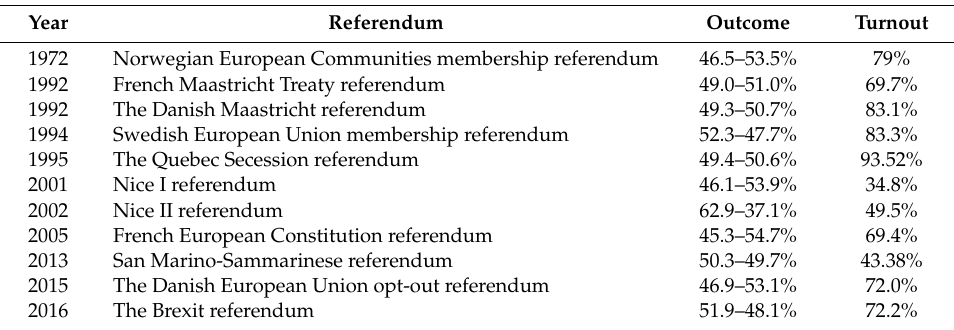
Table 2. Referenda with close